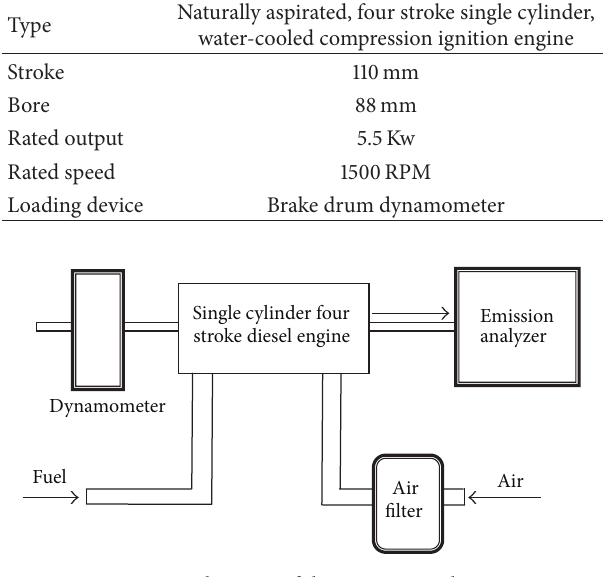
Figure 4: Schematic of the experimental setup.